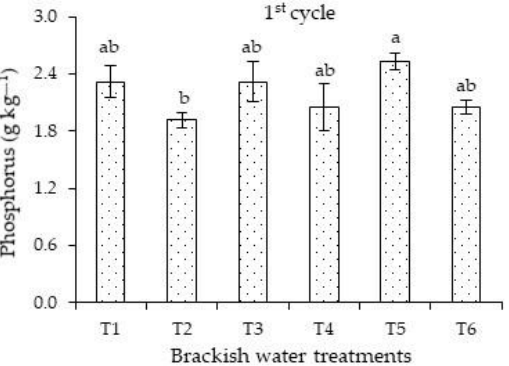
Figure 2. Leaf concentrations of phosphorus of Passiflora edulis Sims as a function of salt stress, varying the phenological stages in the first cycle. Standard error of the mean ( n = 4); Means followed by different letters indicate a significant difference between treatments. T1—irrigation with low- salinity water during the entire cultivation cycle; salt stress in the following stages: T2—vegetative; T3—flowering; T4—fruiting; T5—vegetative and flowering; T6—vegetative and fruiting.